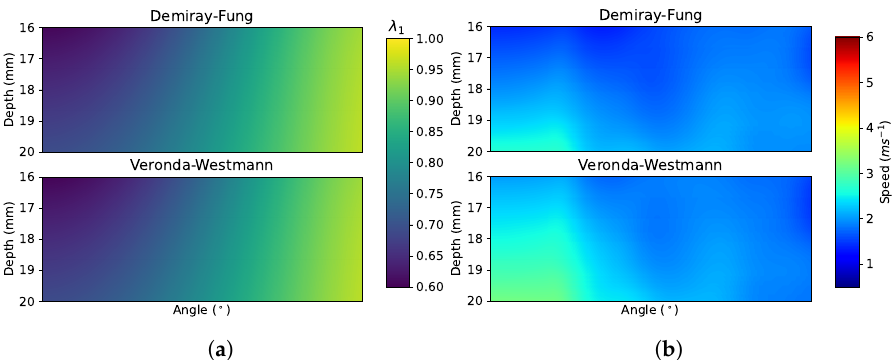
Figure 10. ( a ) Predicted λ 1 values and ( b ) simulated base speed values using predicted material properties for sample elastogram in DF and VW models.